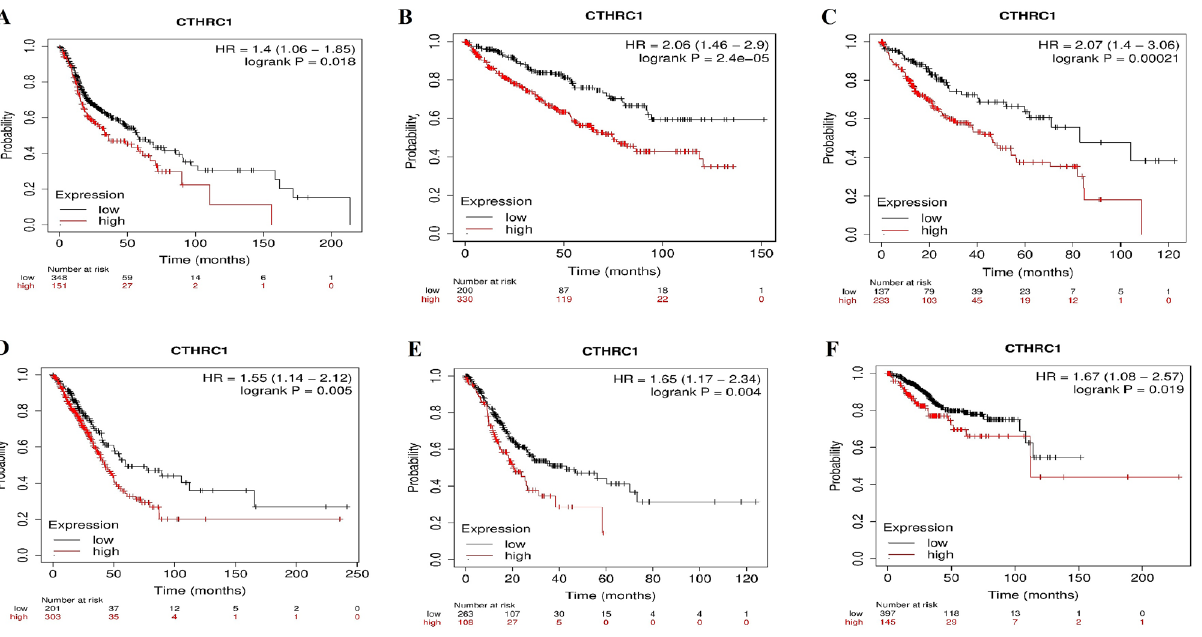
Figure 2. Relationship between CTHRC1 expression and OS duration of the distinct types of cancers. ( A ) HNSC, ( B ) KIRC, ( C ) LIHC, ( D ) LUAD, ( E ) STAD, and, ( F ) UCEC. A p-value of < 0.05 was selected as a cutoff criterion.